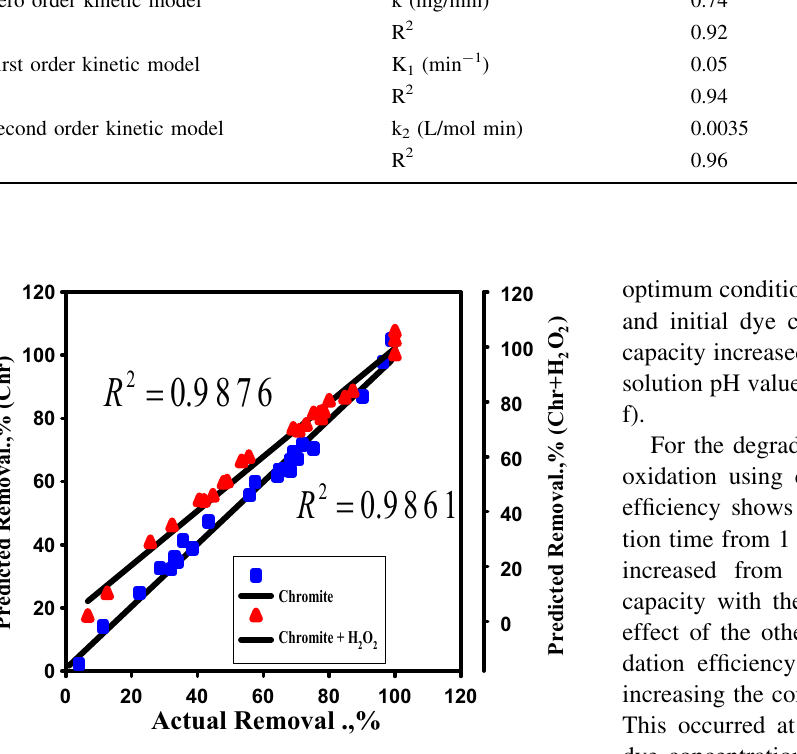
Fig. 8 Correlation between predicted removal of dye and experi- mental